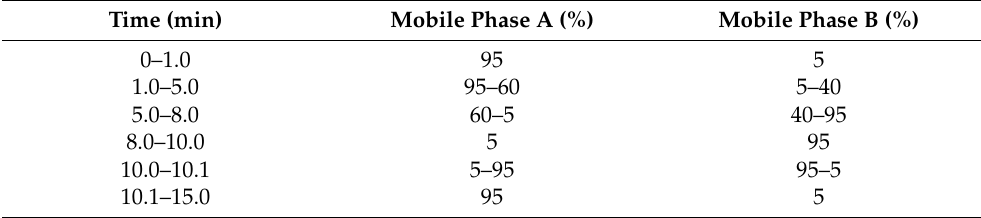
Table 5. Gradient used for the separation of cefquinome, cefquinome-d7, ceftiofur and ceftiofur-d3. With mobile phase A: 0.1% ( v / v ) formic acid and 2mM ammonium formate in H 2 O and mobile phase B: 0.1% ( v / v ) formic acid in